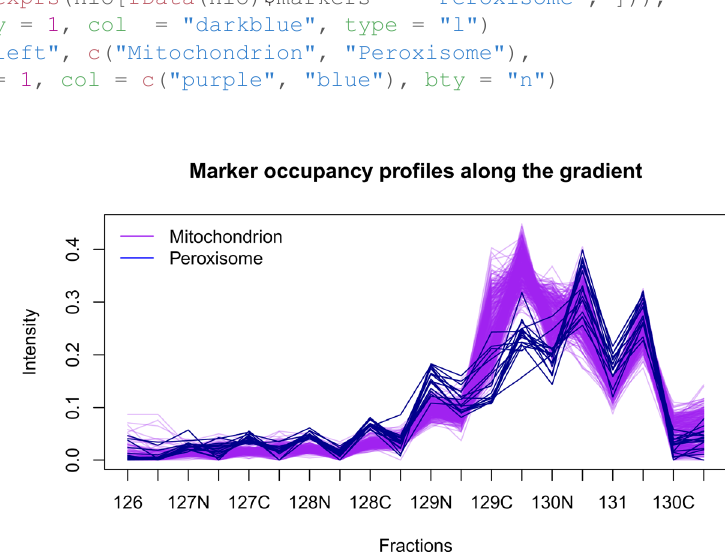
7.Figure 8. Mitochondrion and peroxisome protein